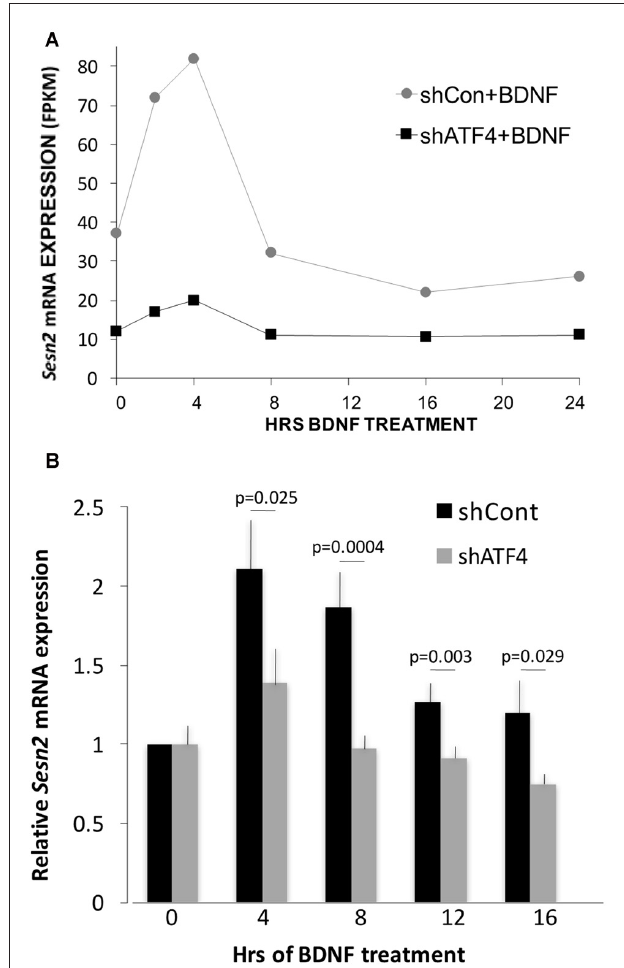
FIGURE 6 | Sesn2 undergoes ATF4-dependent regulation in response to BDNF treatment. (A) RNAseqderived fragments per kilobase per million (FPKM) values for Sesn2 transcripts at various times of exposure to BDNF (25 ng/ml) with or without ATF4 knockdown. Hippocampal neurons were cultured for 7 days and then infected with lenti-shControl or lenti-shATF4. Five days after infection, cultures were treated with BDNF for the indicated times and harvested for RNA which was then subjected to RNAseq. (B) Cultures treated as above were subjected to qPCR for detection of Sesn2 transcripts. Mean values for shControl and shATF4 at 0 time were set to 1 after normalization to alpha-tubulin (mean value for shATF4 was 0.81 ± 0.09 compared with shControl at time 0, p = 0.07 t -test, n = 8). Comparison of values for no BDNF treatment + shControl vs. BDNF + shControl (all time points) by the Kruskal-Wallis test yielded an overall p value of 0.001. The post hoc Conover method adjusted by the FDR procedure of Benjamini-Hochberg provided individual p values (vs. time 0) of 0.00006 (4 h and 8 h), 0.034 (12 h) and 0.09 (16 h). The same comparison for no BDNF treatment + shATF4 (all time points) yielded an overall p value of > 0.05. The indicated p values on the figure are for each time point for shControl vs. shATF4 and were calculated by the t -test, n = 4–7 independent experiments, each performed with one sample per time point.